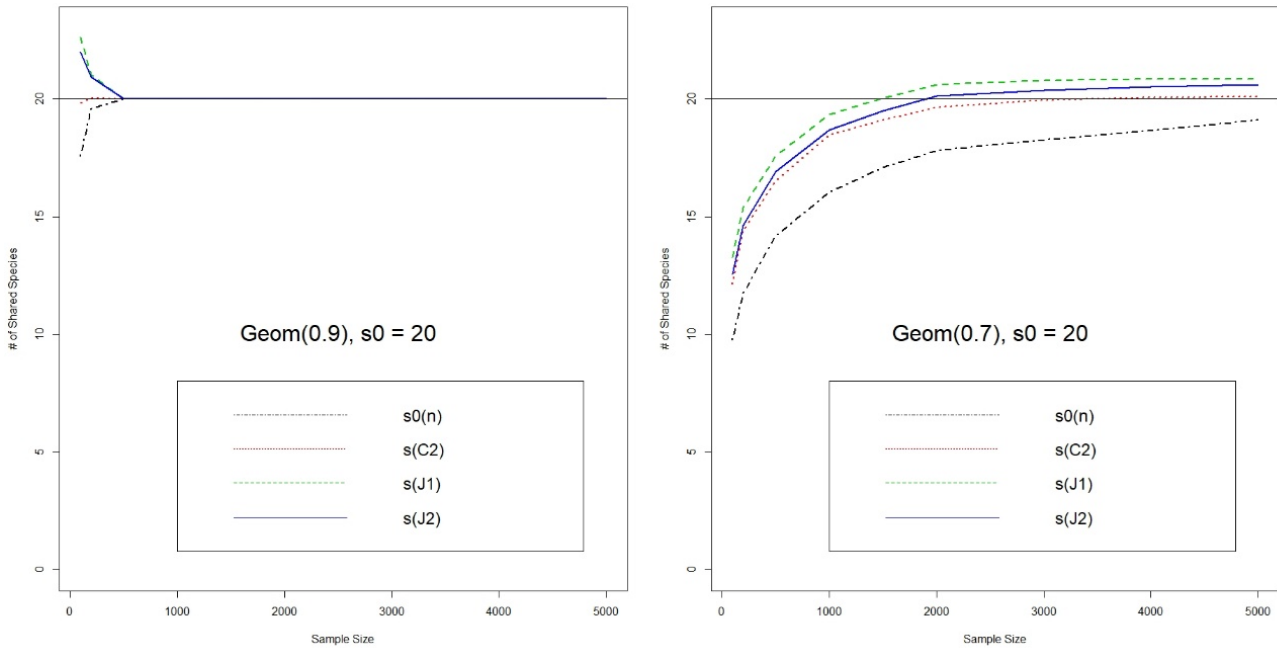
= s ; J1 & J2: 1st & 2nd Jackknife 0